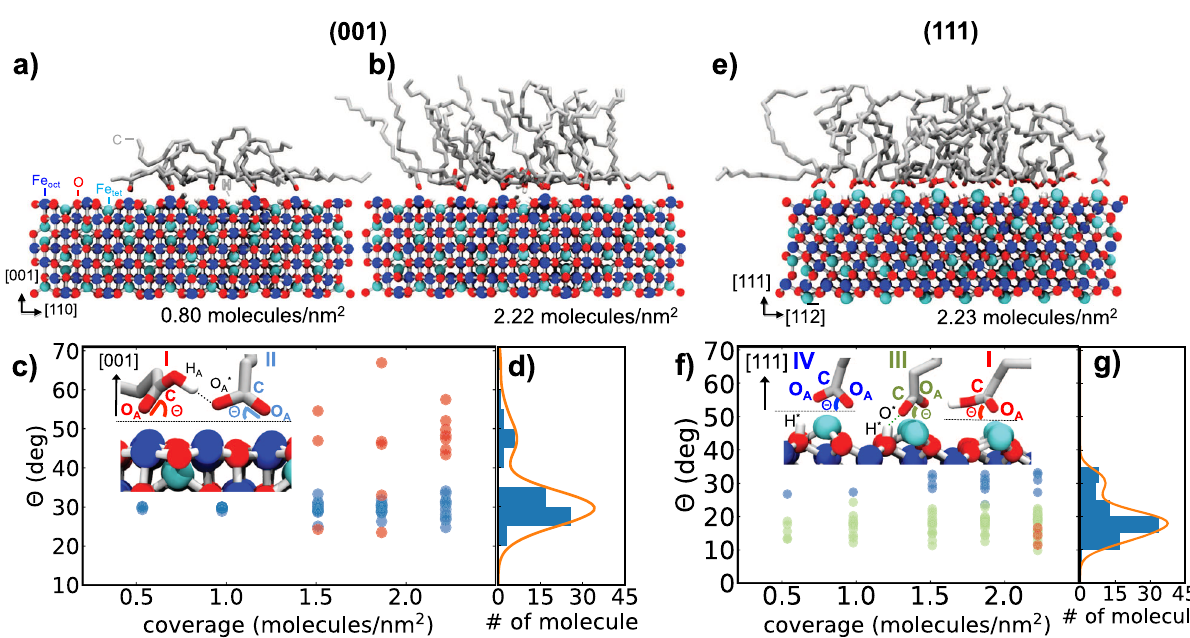
Fig. 5 Ligand structure of OLAC on magnetite. Ligand structure on magnetite (001) ( a , b ) and on (111) ( e ) at OLAC/oleate coverages indicated below the structures. Exemplary adsorption con fi gurations of OLAC/oleate on magnetite, i.e. molecular (I), bidentate (II), quasi-bidentate (III) and chelating (IV), are shown in the insets of ( c ) and ( f ) and are explained in the main text. Different colors are used in ( c ) and ( f ) to indicate angles Θ between C – O A (C = O A in the case of OLAC) and the surface plane. Colors refer to the structures (I – IV) given in the inset. Histograms in ( d ) and ( g ) show the distribution of Θ for the highest coverage on both